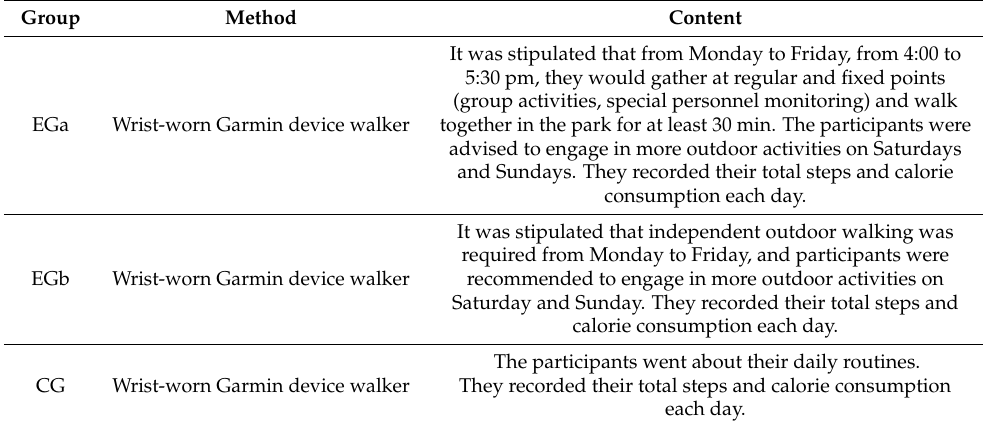
Table 2. The experimental methods of the three